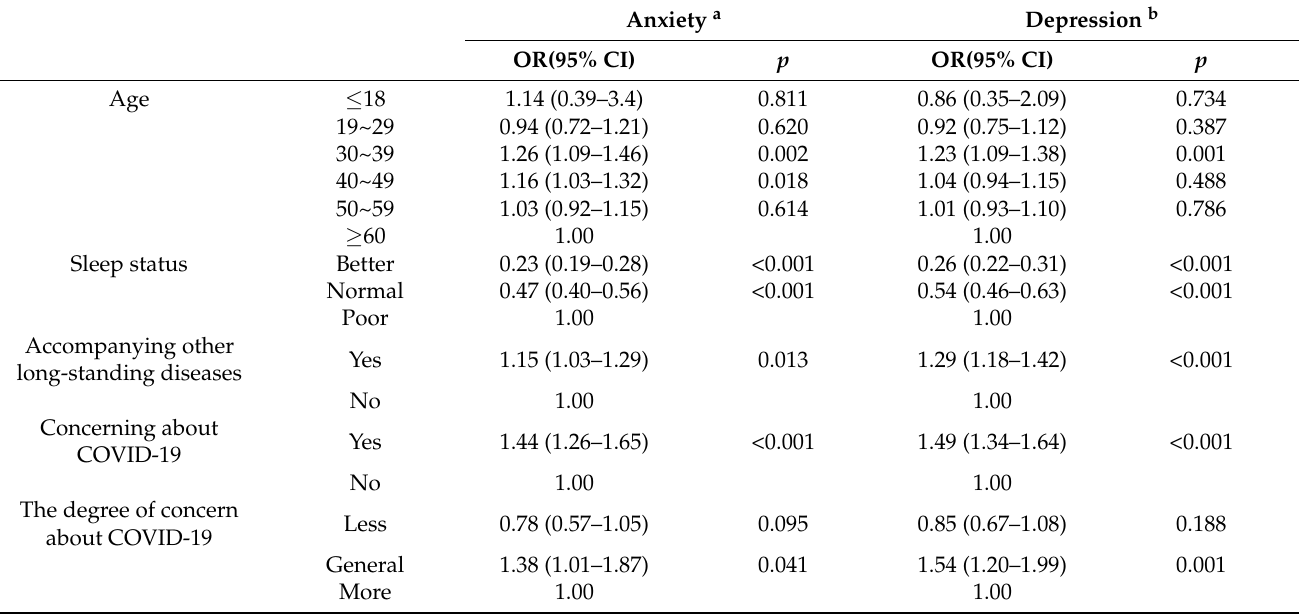
Table 4. Logistic regression analysis of anxiety and depression in patients with schizophrenia in the community. Anxiety